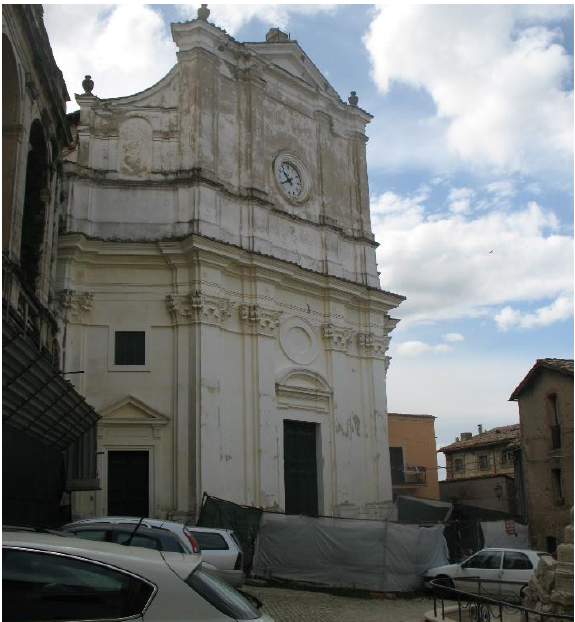
Figure 2. Current photo of the church’s facade of Maria SS. Assunta in Cielo, located in Cantalupo in Sabina (RI).